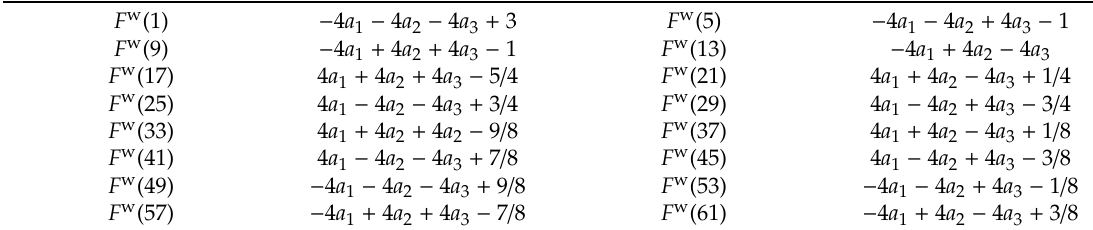
Table 2. Walsh coe ffi cient matrix [F].